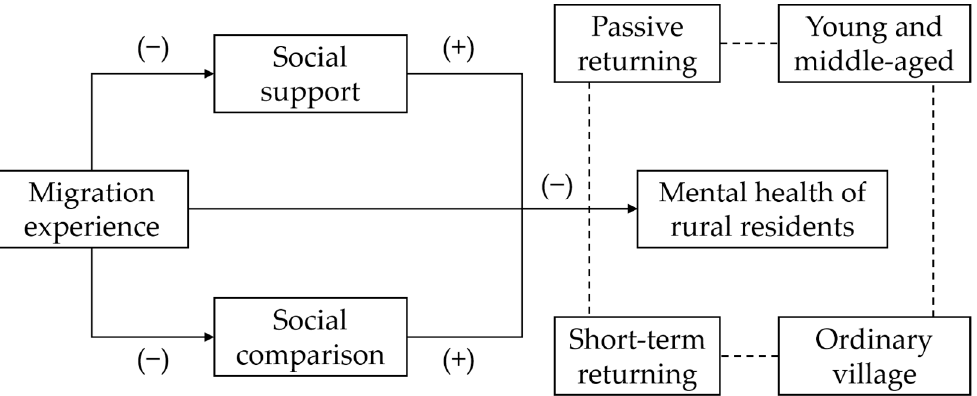
Figure 1. The impact of migration experience on rural residents’ mental health.